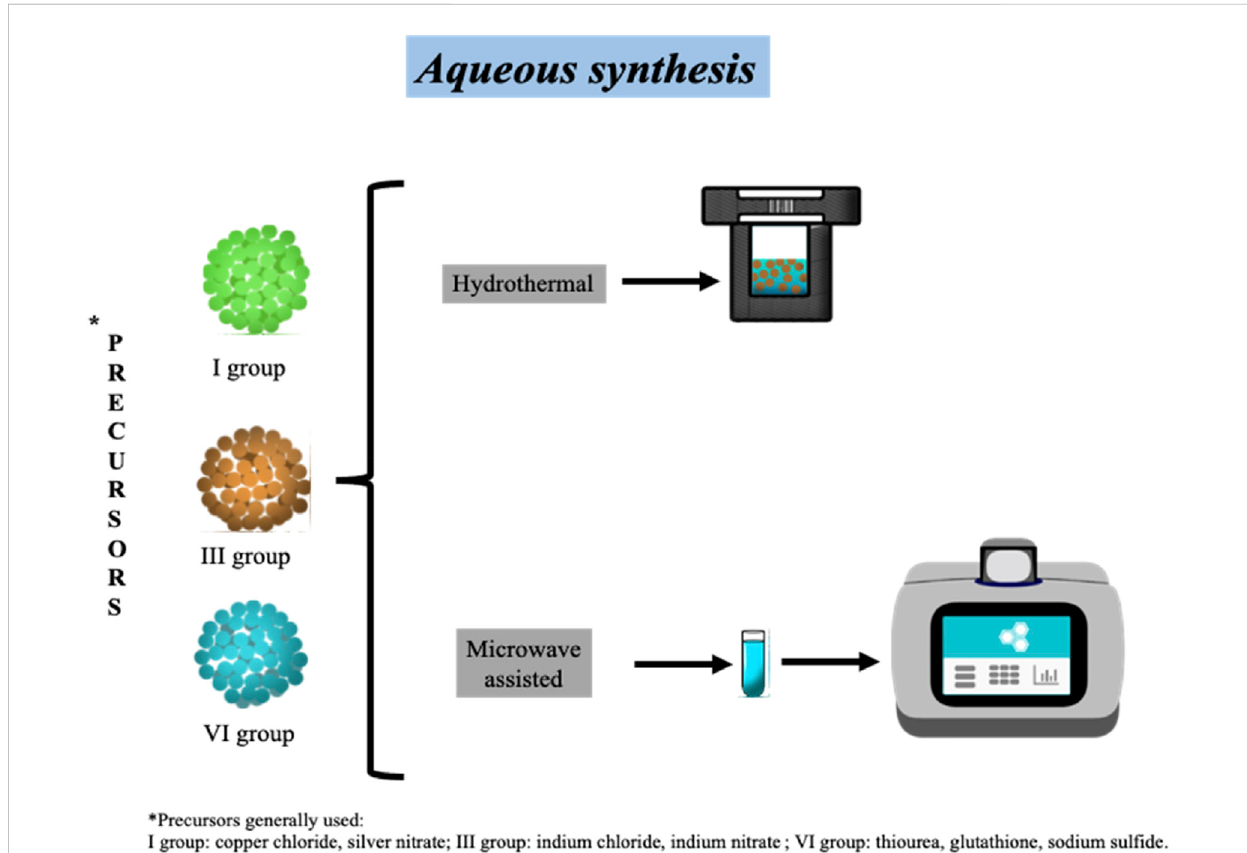
FIGURE 2 Aqueous synthesis of ternary quantum dots by hydrothermal and microwave-assisted